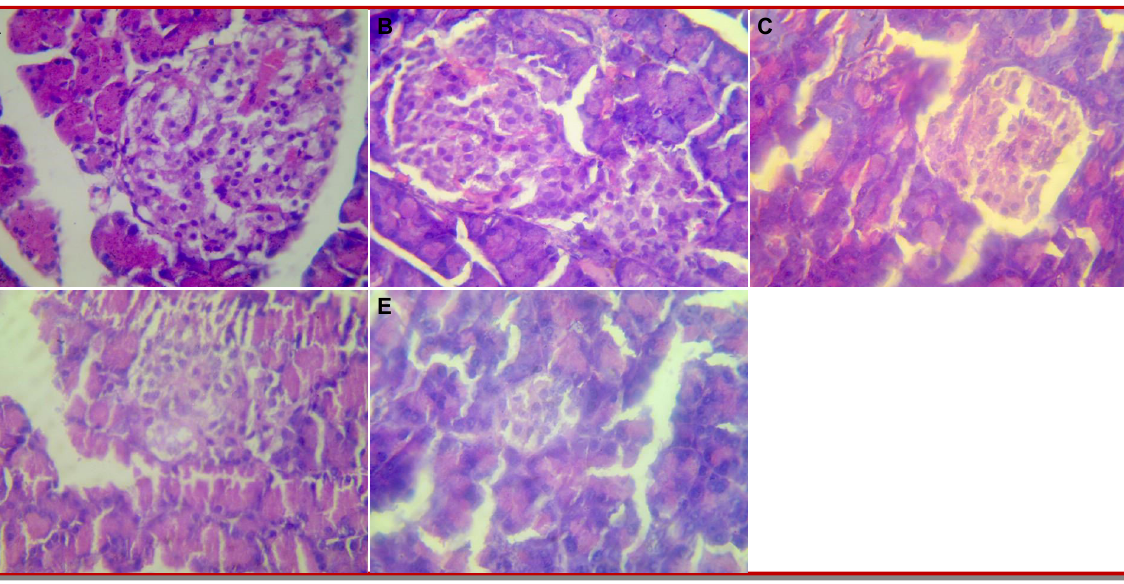
Figure 1: Histology of treated animal pancreas. (A) Normal control rat; (B) Glibenclamide treated rat pancreas; (C) STZ treated rat pancreas; (D) A. alnifolia acetone extract treated; (E) A. alnifolia methnol extract treated rat